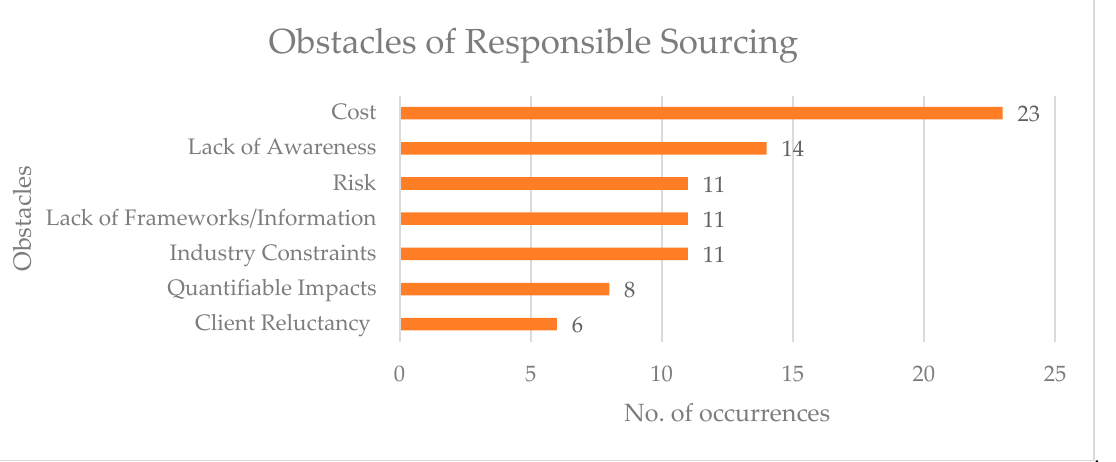
Figure 6. This shows the obstacles (n = 7) to responsible sourcing and the frequency of their report- ing in the AEC publications (n = 80) used in the literature review.